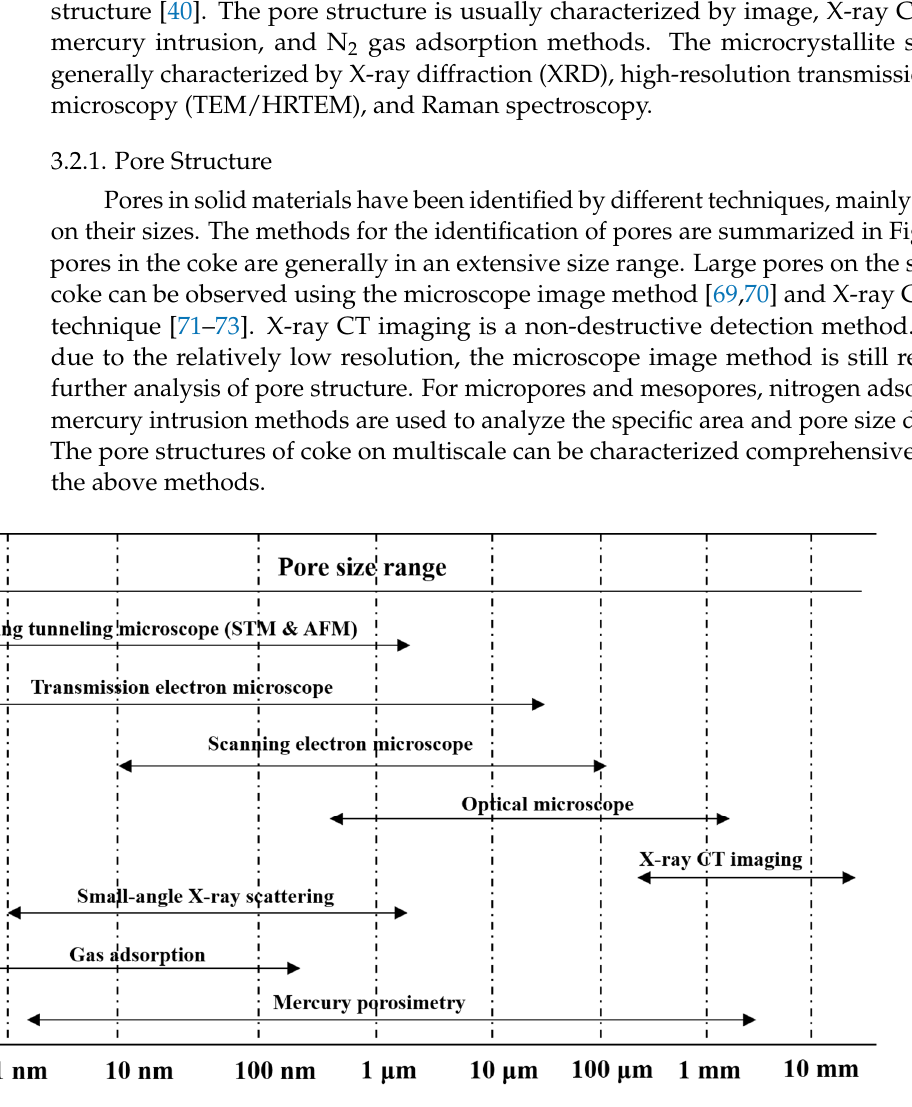
Figure 7. Identification techniques of pores in in solid materials. Microscope Image Method